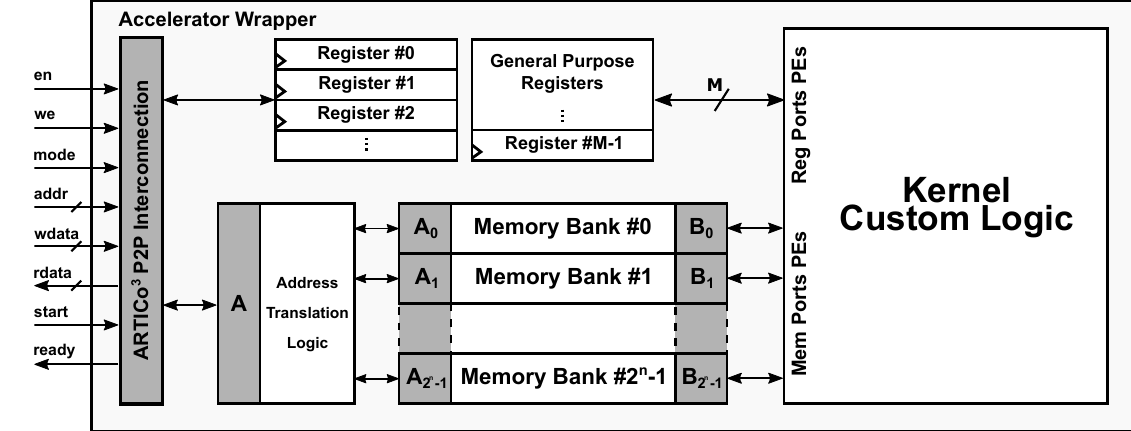
Figure 8. ARTICo 3 wrapper. The configurable structure (i.e., number of configuration registers or memory banks) is tailored for each functionality that is to be